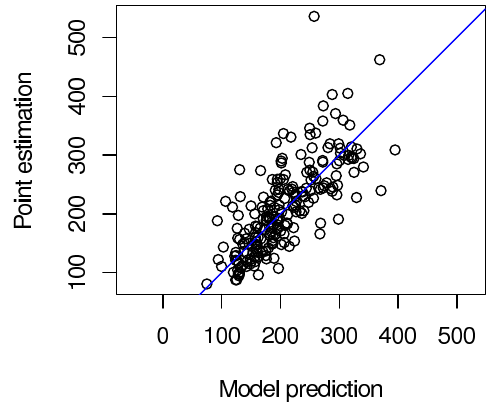
Fig. 3. Scatter plot of 100-yr return levels estimated locally versus the return levels predicted by RS2. Pearson’s correlation is 0.79. Fig.3. Scatterplotof100-yearreturnlevelsestimatedlocallyversus the return levels predicted by RS2. Pearsons correlation is 0.79.